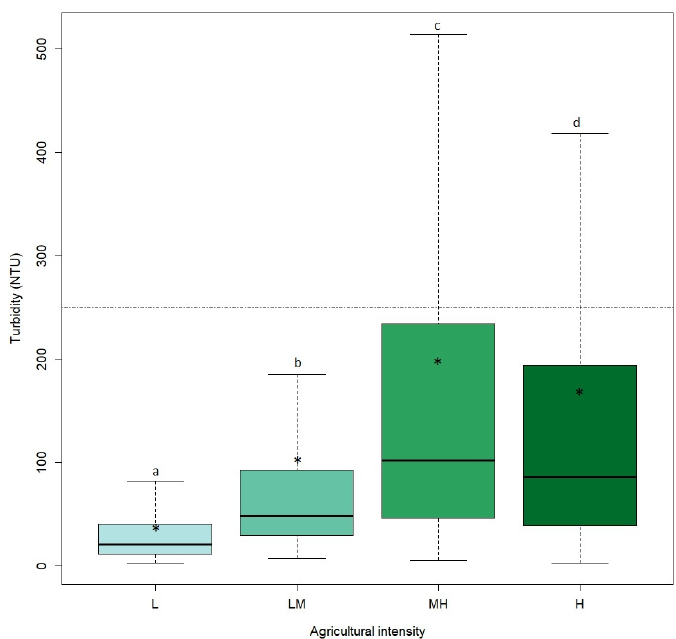
Figure 3. Box and whiskers plot with outliers excluded of turbidity among agricultural intensities in the Cache River Watershed, Arkansas sampled weekly from October 2017 to September 2020. The solid black line represents the median turbidity, the asterisk represents mean turbidity, the solid lines above and below the box represent the 75th and 25th percentiles, and the black dashed line represents the 250 NTU limit. Differences in lowercase letters indicate a significant difference ( α = 0.05) among intensities.